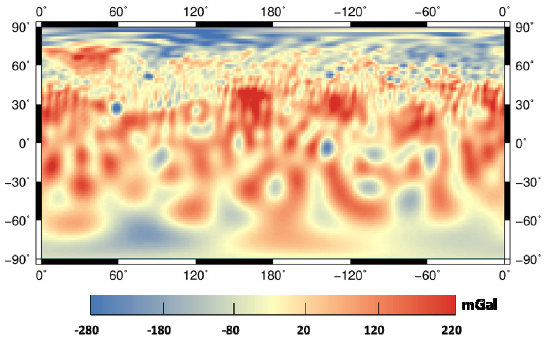
Figure 1. Stripe noises (in the red box) on 100-degree gravity field grid of Mercury.